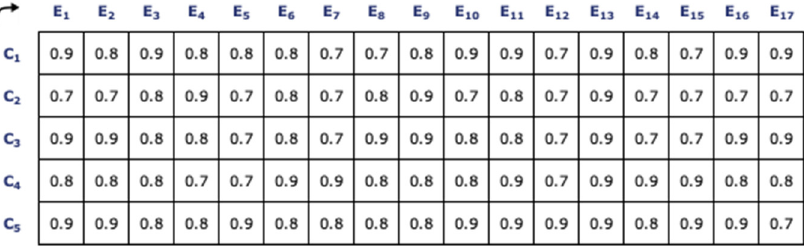
Figure A4. Cumulative effects matrix.